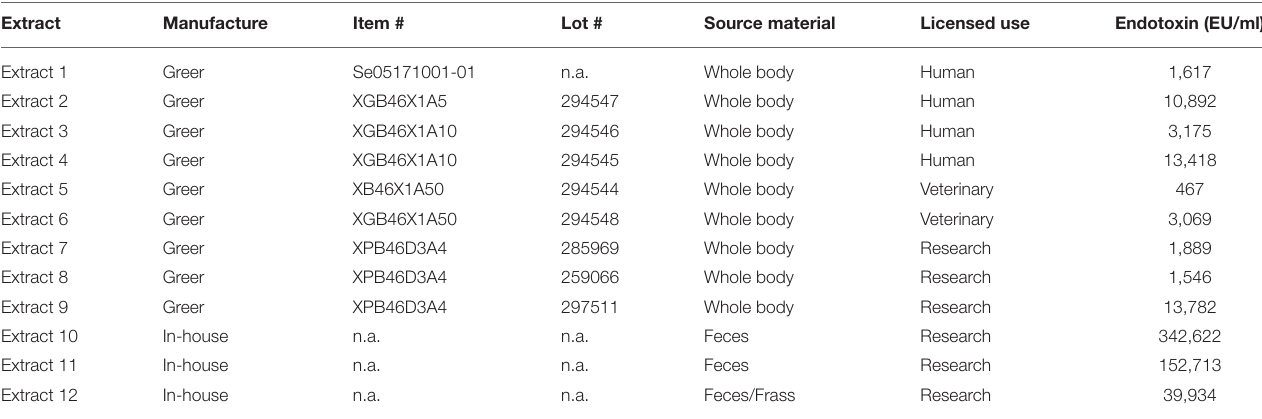
TABLE 2 | German cockroach extract summary showing origin of manufacture, lot numbers, source material, licensed use and Endotoxin content.